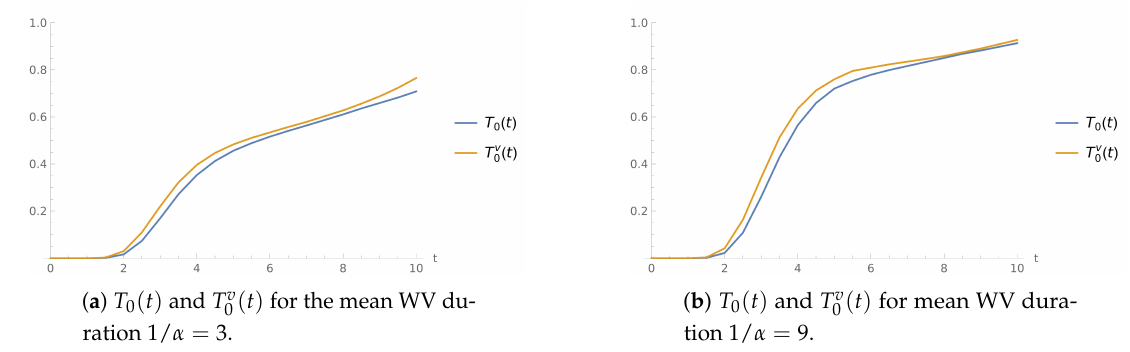
Figure 1. The time to buffer overflow CDFs for µ = 19 and µ v = 9.